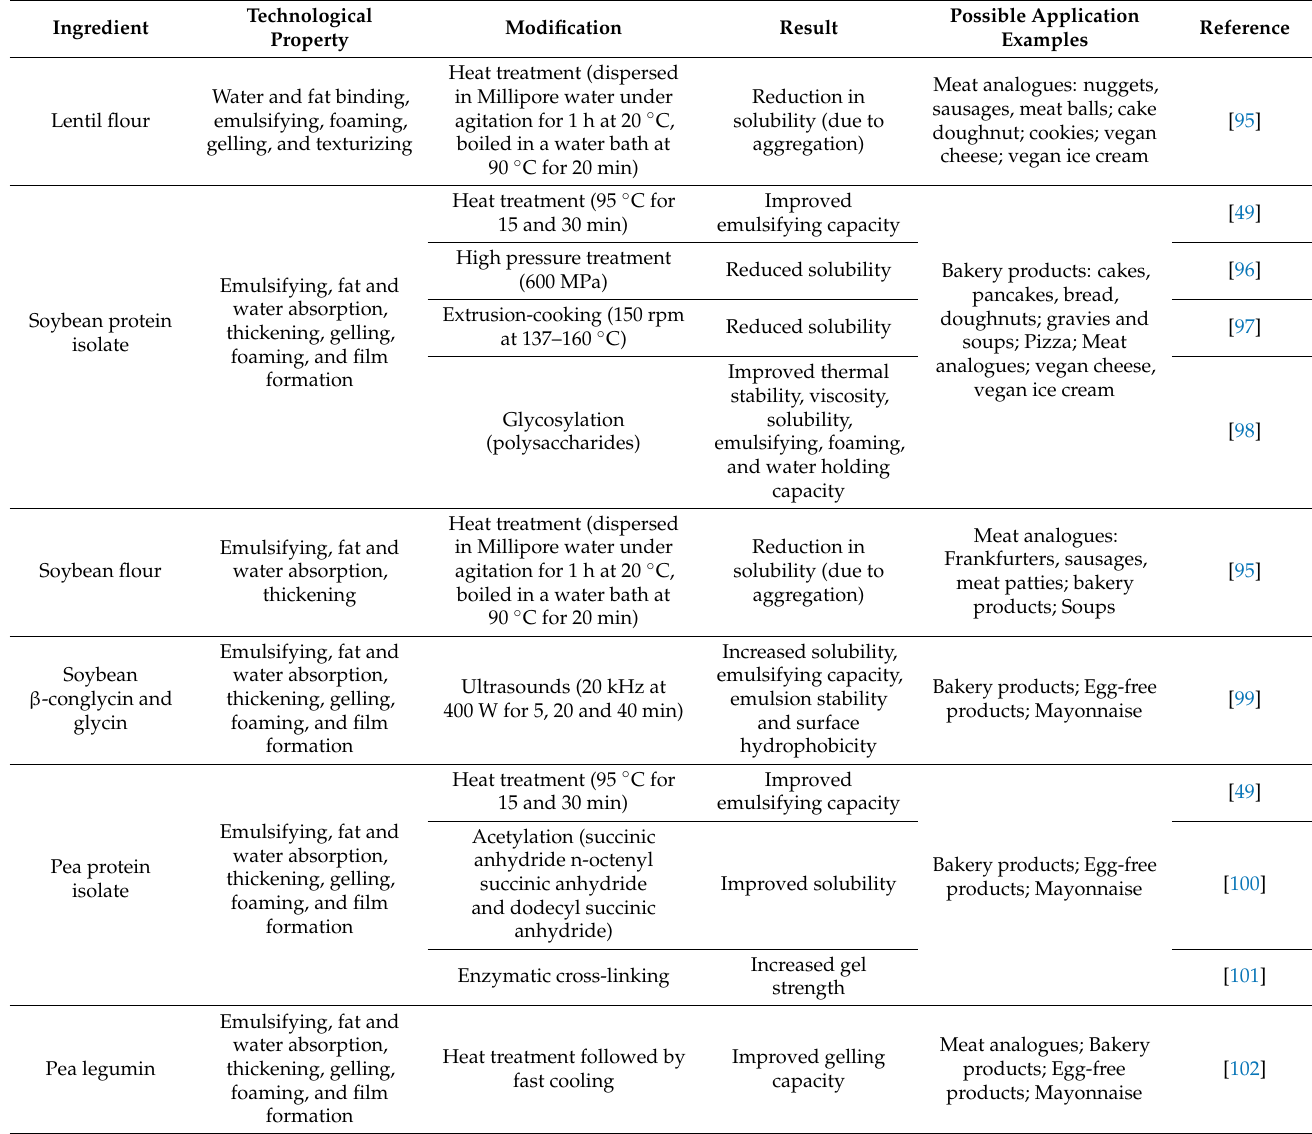
Table 2. Technologies used in the literature to modify legume proteins for the improvement of technological